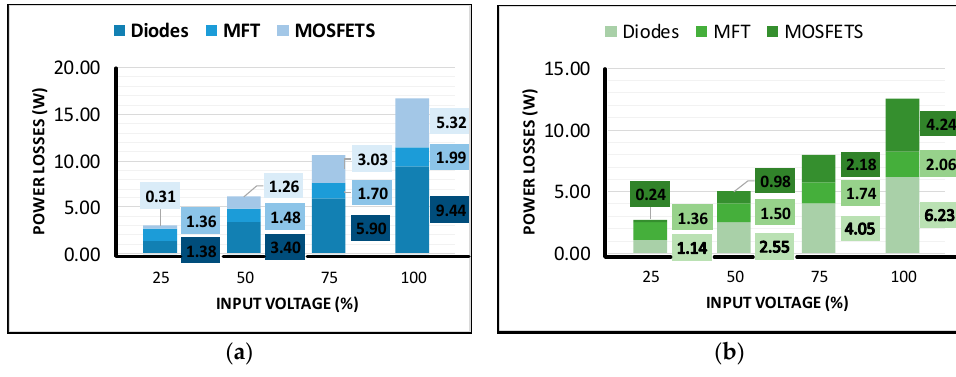
Figure 14. Percentage of losses in the converter of ( a ) 2L and ( b ) 3L.